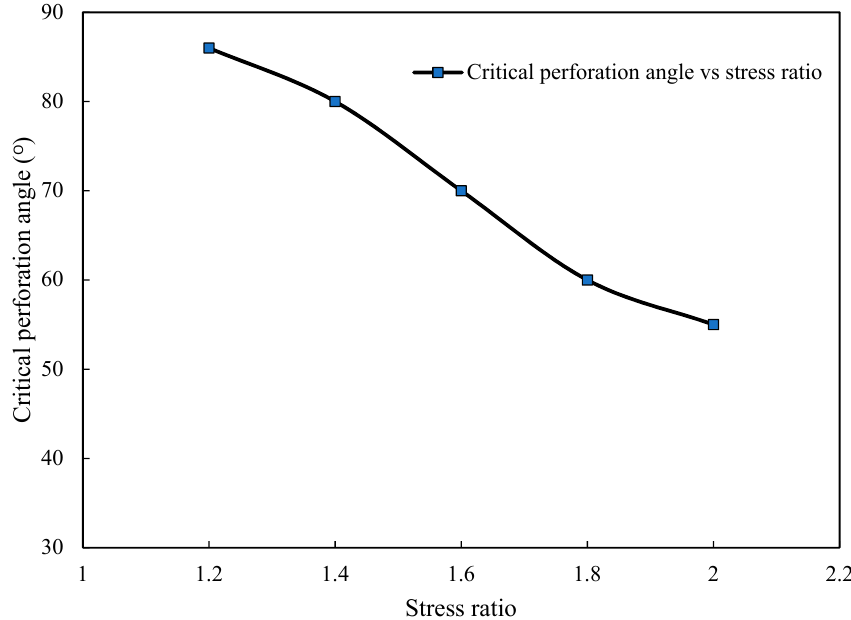
Figure 11. The relationship between critical perforation angle and stress ratio.